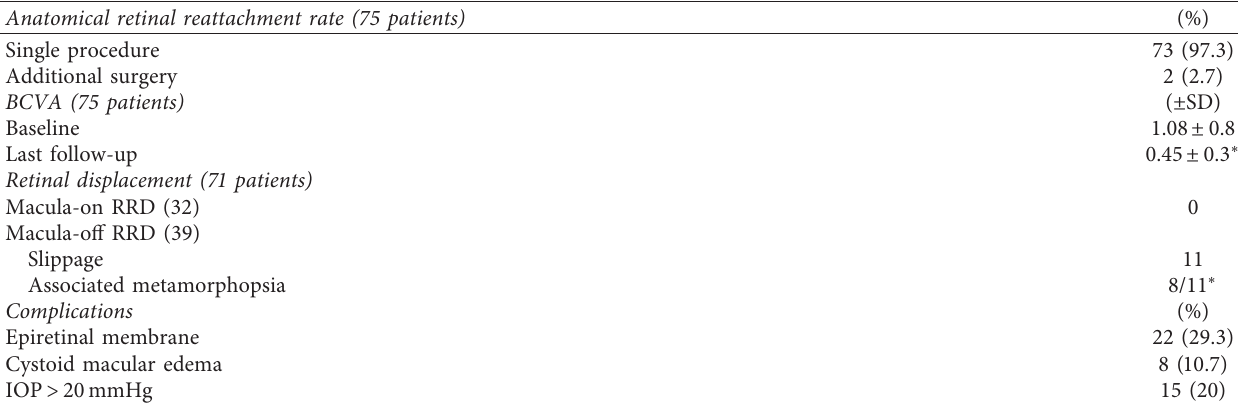
Figure 3: FAF (a) and SD-OCT (b) images six weeks after macula-off RRD surgery. White arrows pointing to hyperfluorescent lines (a) indicate the preoperative position of retinal vessels. Retinal displacement was not observed in cases of macula-on RRD. Table 4: Study